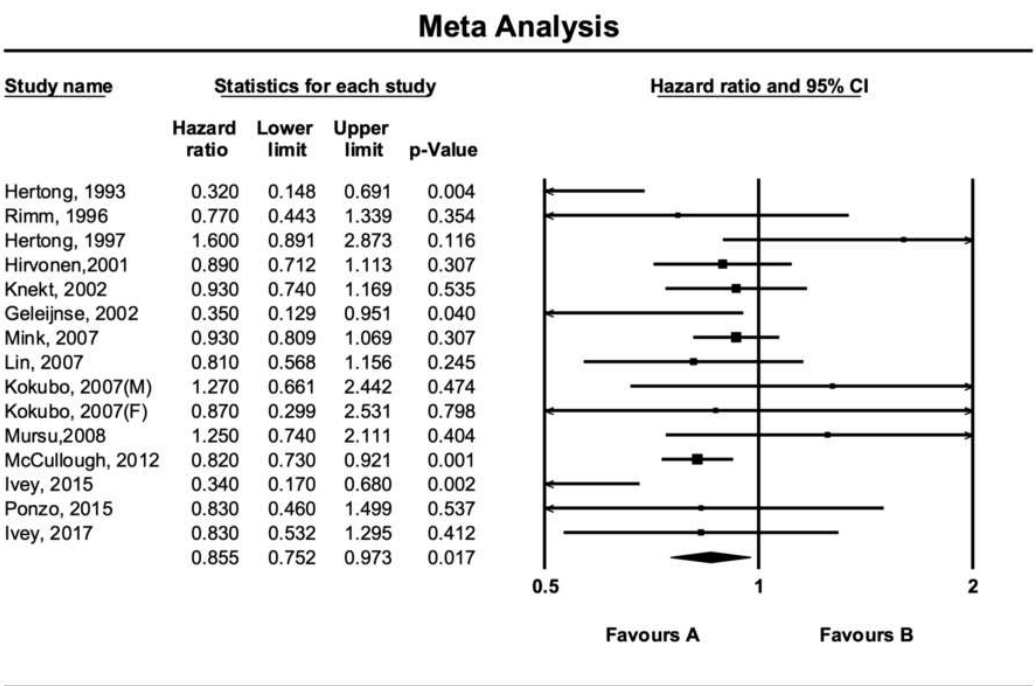
Nutrients 2020 , 12 , x FOR PEER REVIEW Figure 3. Forest plot of flavonoid intake and risk of cardiovascular disease mortality.